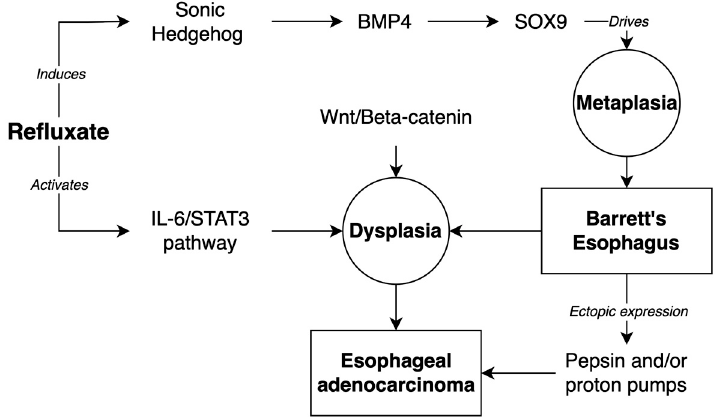
Figure 1. Molecular pathways of development of Barre tt ’s Esophagus and progression to Esophageal Adenocarcinoma.